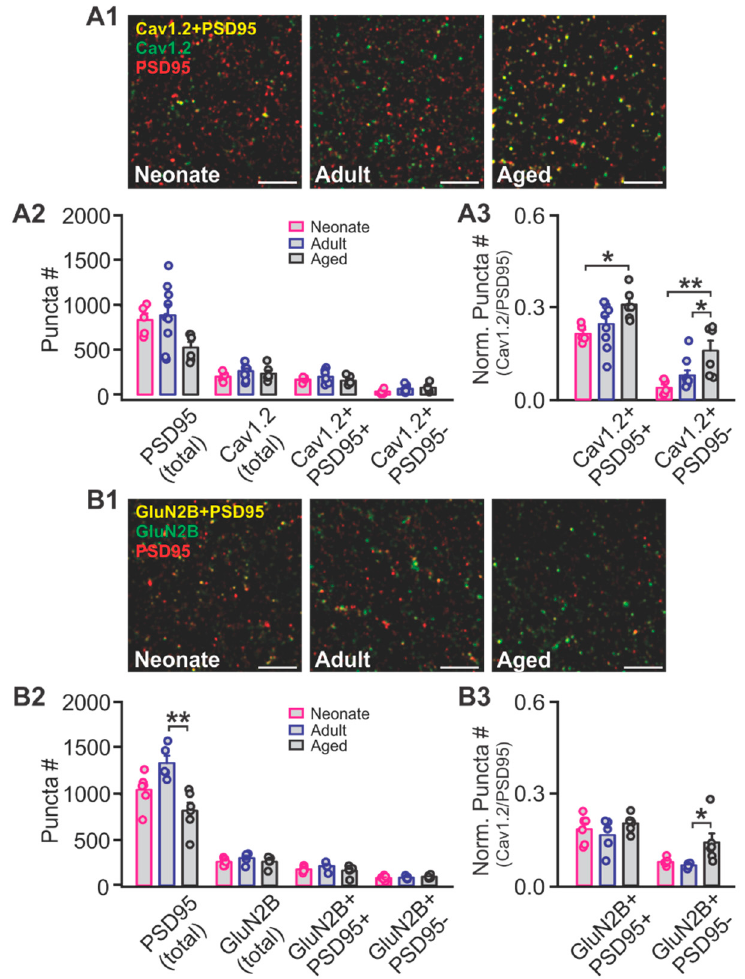
Figure 5. Age-dependent Cav1.2 and GluN2B expressions in the piriform cortex layer Ib. ( A1 ) Ex- ample staining of Cav1.2 and PSD95 in neonate, adult and aged PC layer Ib. Scale bars, 5 µ m. ( A2 ) Puncta numbers of Cav1.2 and PSD95. ( A3 ) Normalized punta numbers of Cav1.2 over PSD95. ( B1 ) Example staining of GluN2B and PSD95 in neonate, adult and aged PC layer Ib. Scale bars, 5 µm. ( B2 ) Puncta numbers of GluN2B and PSD95. ( B3 ) Normalized punta numbers of GluN2B over PSD95. * p < 0.05; ** p < 0.01.